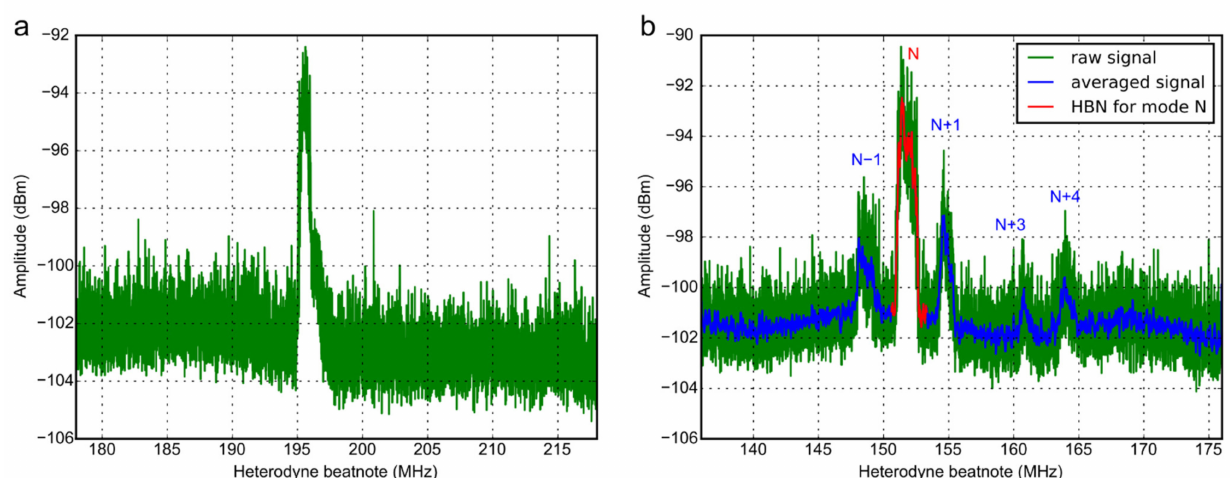
Figure 6. Acquisition of the heterodyne beatnotes signal (HBN) on the spectrum analyzer, resulting from the mixing of the OR- and QCL- frequency combs, characterized by their intermodal frequencies f rep and f IBN , on the Hot-Electron Bolometer. The HBNs are: ( a ) Collapsed when f rep = (f rep ) 0 , submultiple of f IBN ; ( b ) corresponding to the optical modes when f rep is slightly detuned from (f rep ) 0 , where modes are equally spaced by D. Resolution bandwidths = 10 Hz, blue: Averaged signal, red: Most intense mode M